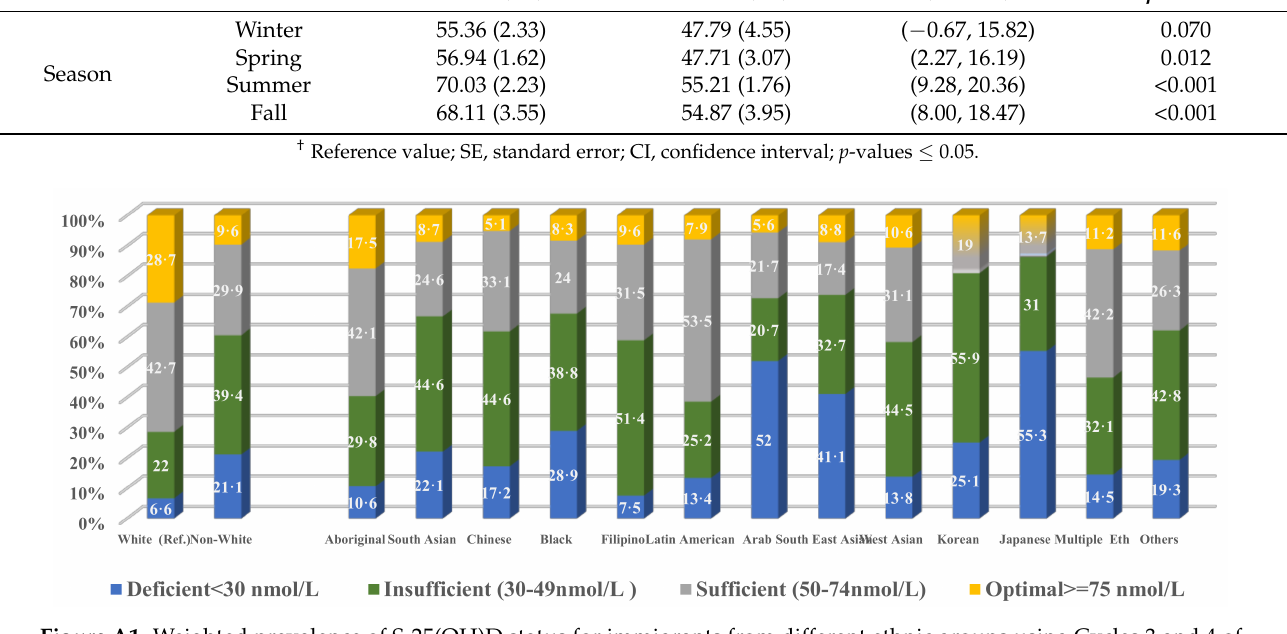
Figure A1. Weighted prevalence of S-25(OH)D status for immigrants from different ethnic groups using Cycles 3 and 4 of Canadian Health Measures Survey